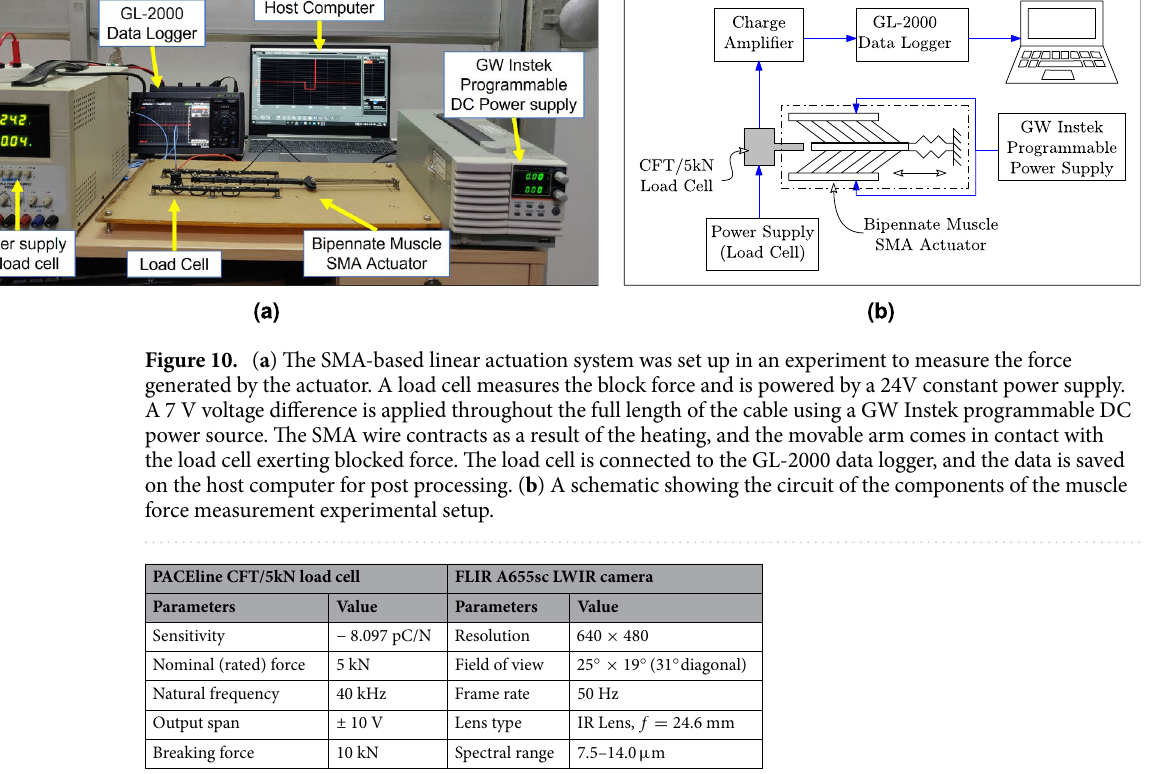
Table 2. Technical parameters of PACEline CFT/5kN piezoelectric force transducer and FLIR A655sc high- resolution science grade LWIR camera.